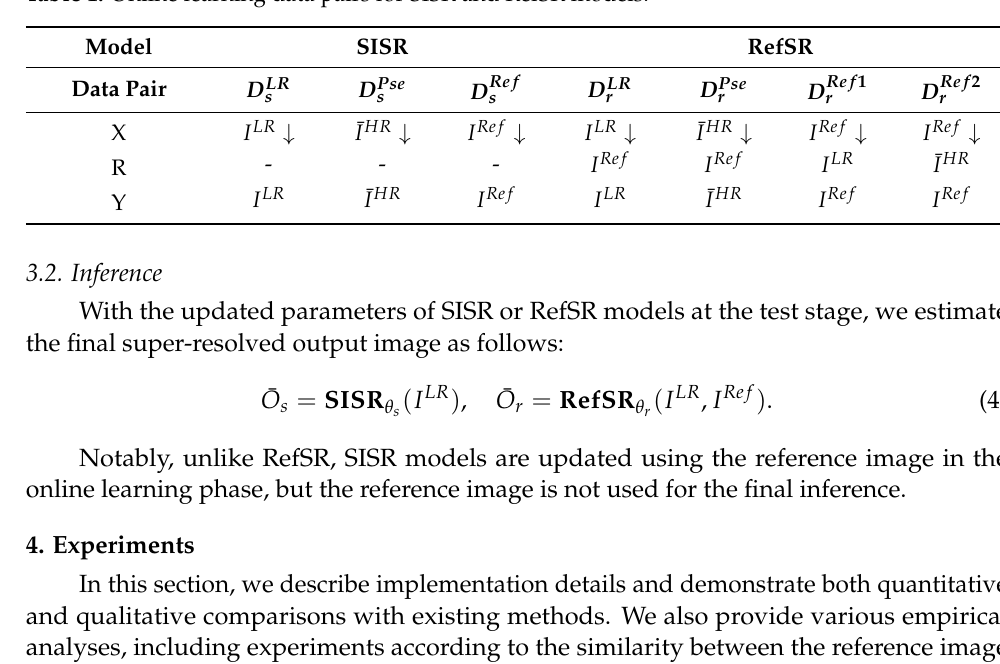
Table 1. Online learning data pairs for SISR and RefSR